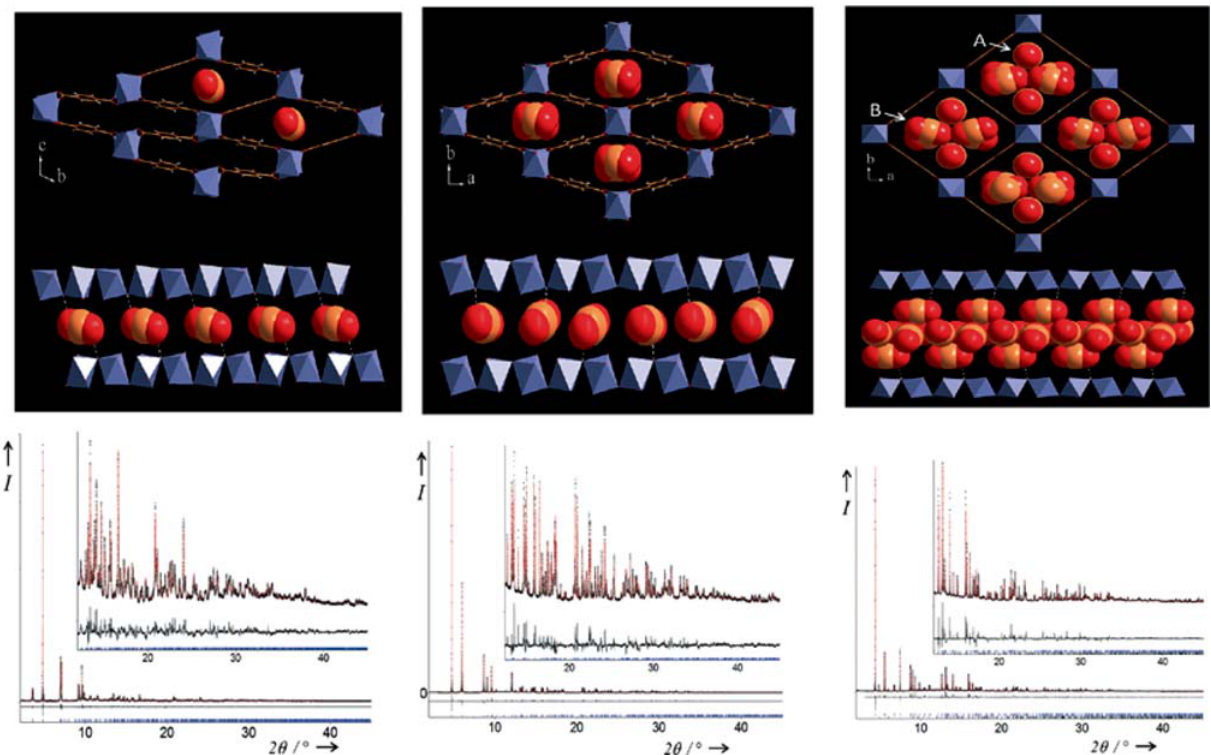
Figure 7. MIL-53(Fe) structure perspective along the 1-D channels (upper images) and perpendicular to the channels (lower images) with determi- ned crystallographic positions of CO with corresponding Rietveld plots. 108 Reprinted with permission. Copyright Royal Society of